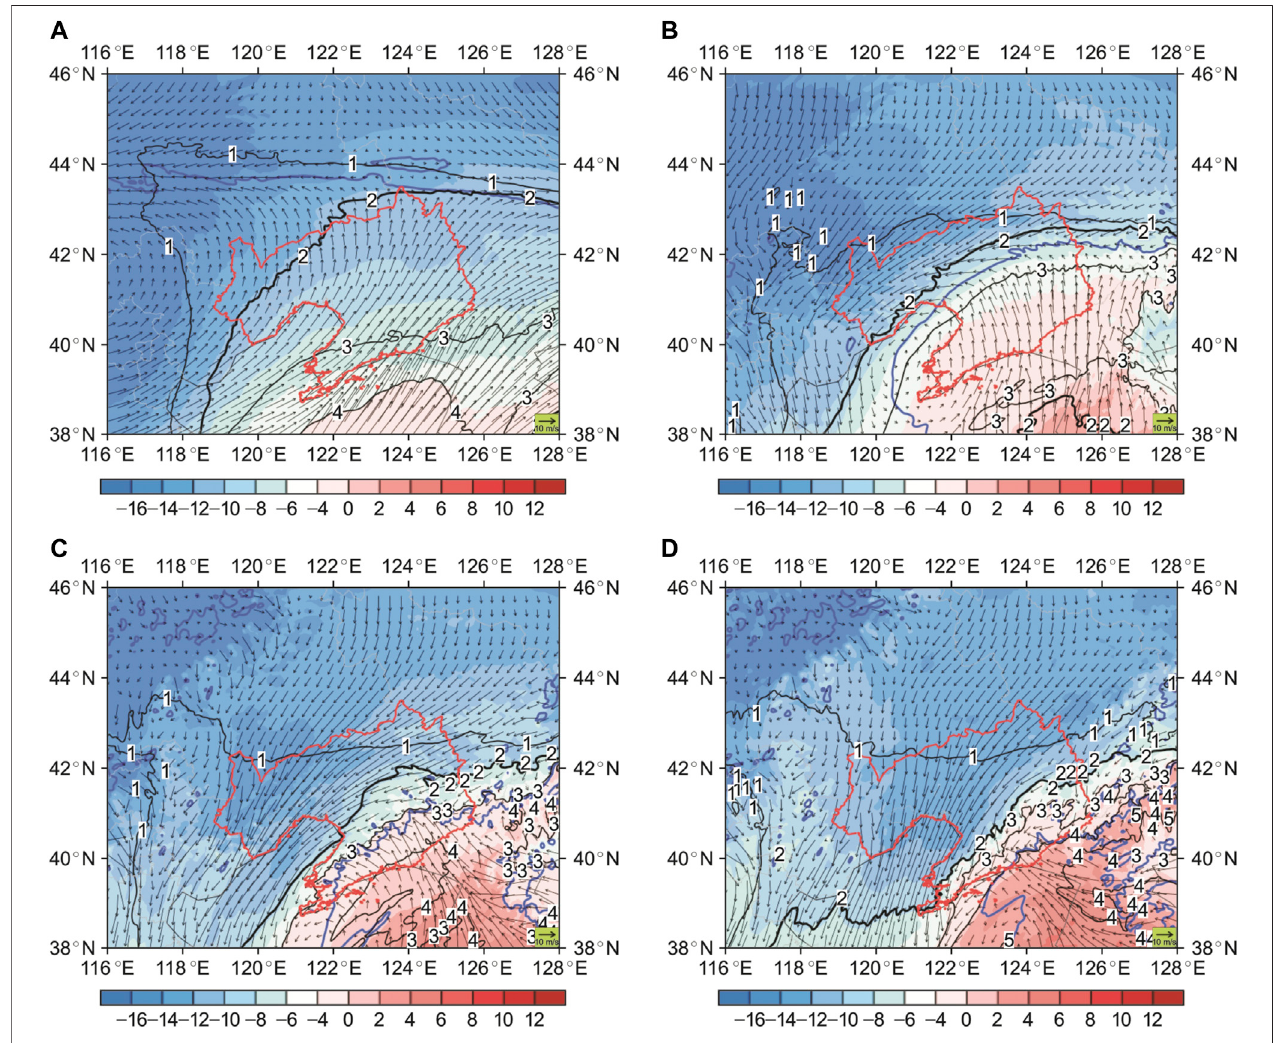
FIGURE8| Temperature,speci fi chumidity,andwindat700 (A) ,850 (B) ,925 (C) ,and975 (D) hPaat1:00onDay2(unit,temperature: ° C,speci fi chumidity:g/kg, wind speed: m/s, blue bold solid line: wind shear lines).